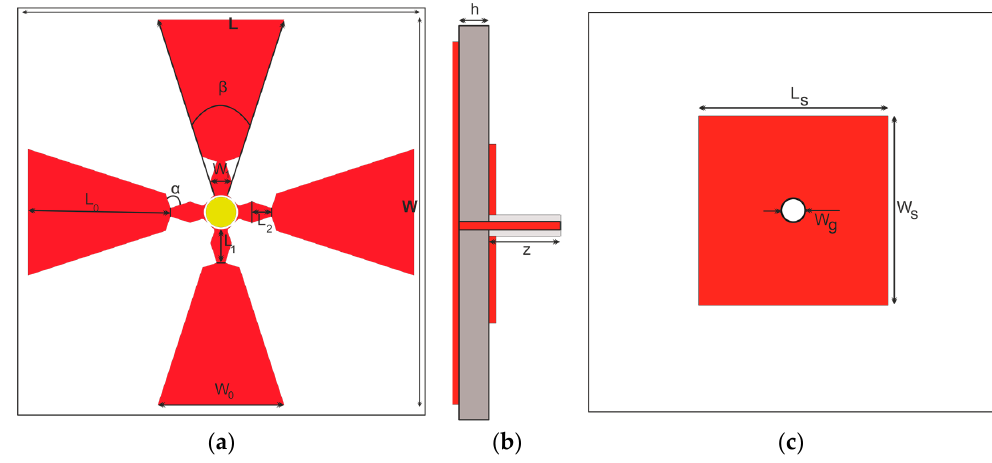
Figure 1. The designed reconfigurable antenna: ( a ) Top view; ( b ) side view; ( c ) bottom view.